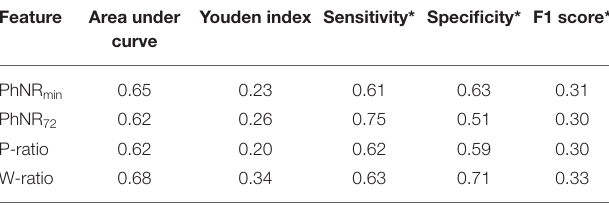
TABLE 2 | Receiver operating curve analysis for classification of optic neuropathy using user-defined ERG features in all the